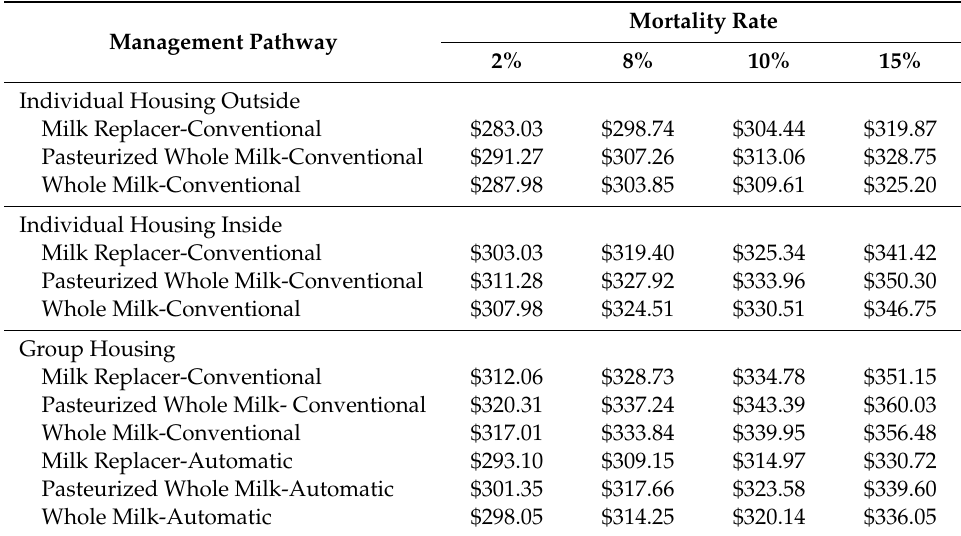
Table 6. Total cost under each management pathway per calf when mortality rate is set at 2, 8, 10, and